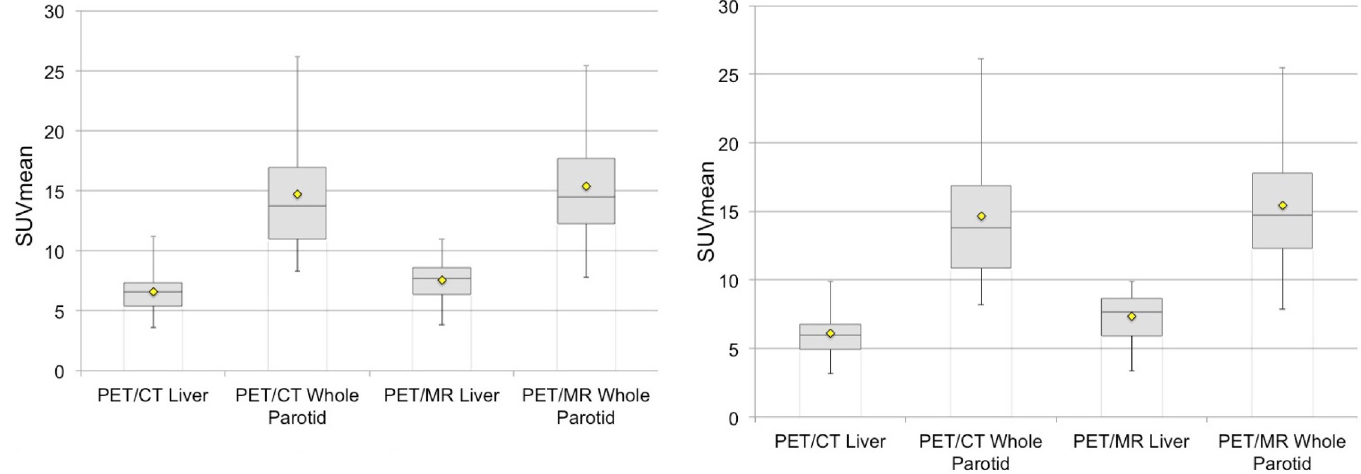
Fig 5. Box plots for SUV mean of the liver and whole parotid gland regions of interest (ROIs) from both PyL PET/CT and PET/MR demonstrates greater interquartile and min-max range for the parotid compared to liver for both readers, reader 1 (A) and reader 2 (B) respectively. Box defines median and 1st and 3rd quartiles. Whiskers are maximum and minimum. Diamond defines the mean